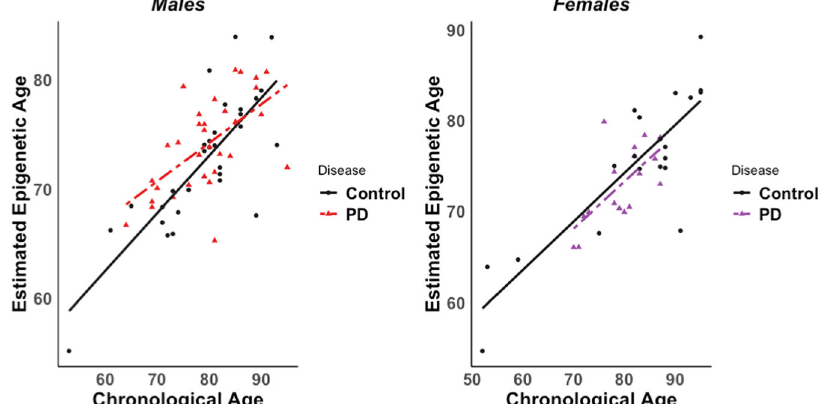
Fig. 6 Scatterplots of male and female estimated epigenetic age vs. chronological age at death. Estimated epigenetic age showed a signi fi cant positive association with chronological age in males (left) and females (right). However, PD status did not signi fi cantly modify trajectories of epigenetic age. Control samples are shown as black dots, and PD samples are shown as red or purple triangles for males and females,